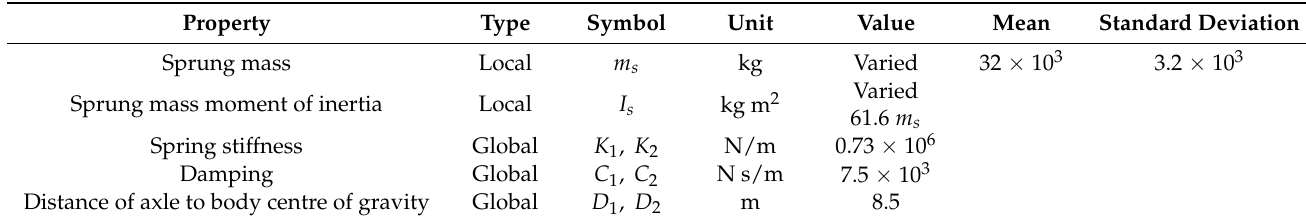
Table 2. Vehicle properties used to calculate